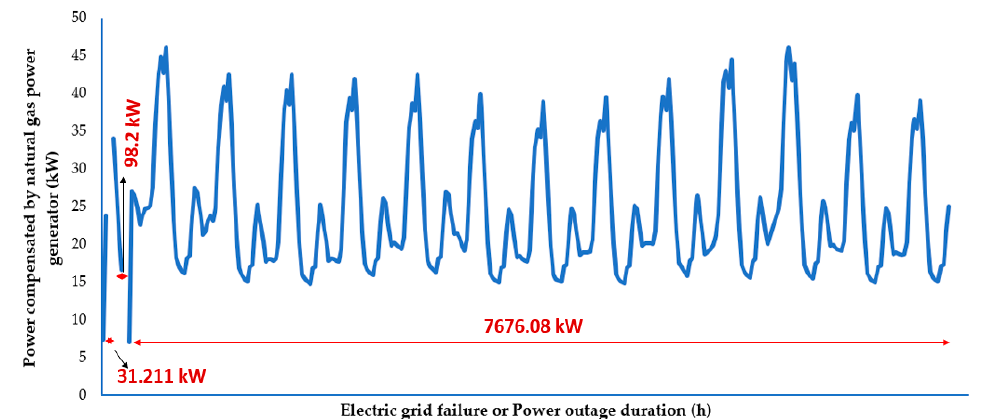
Figure 14. Power compensated by the natural gas power generator.